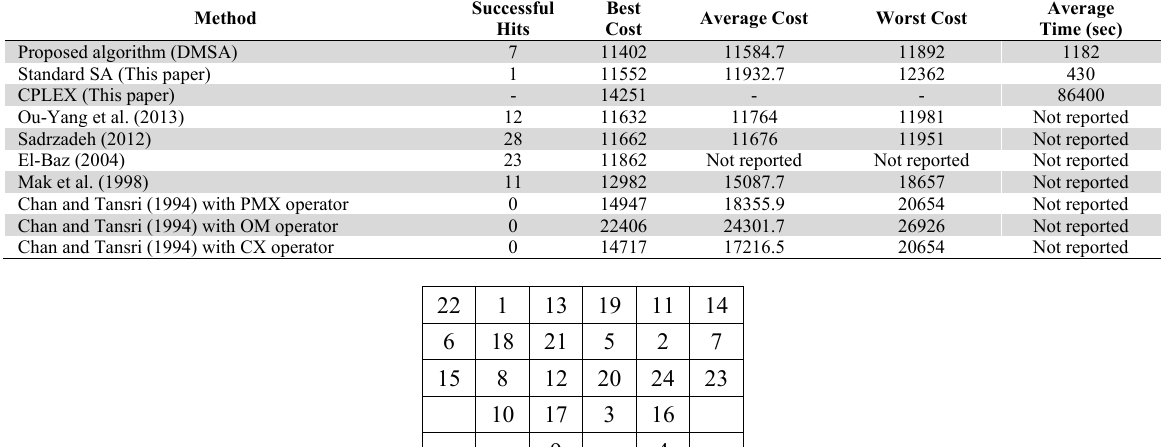
A comparison of the performances of different methods on problem 1 over 30 runs